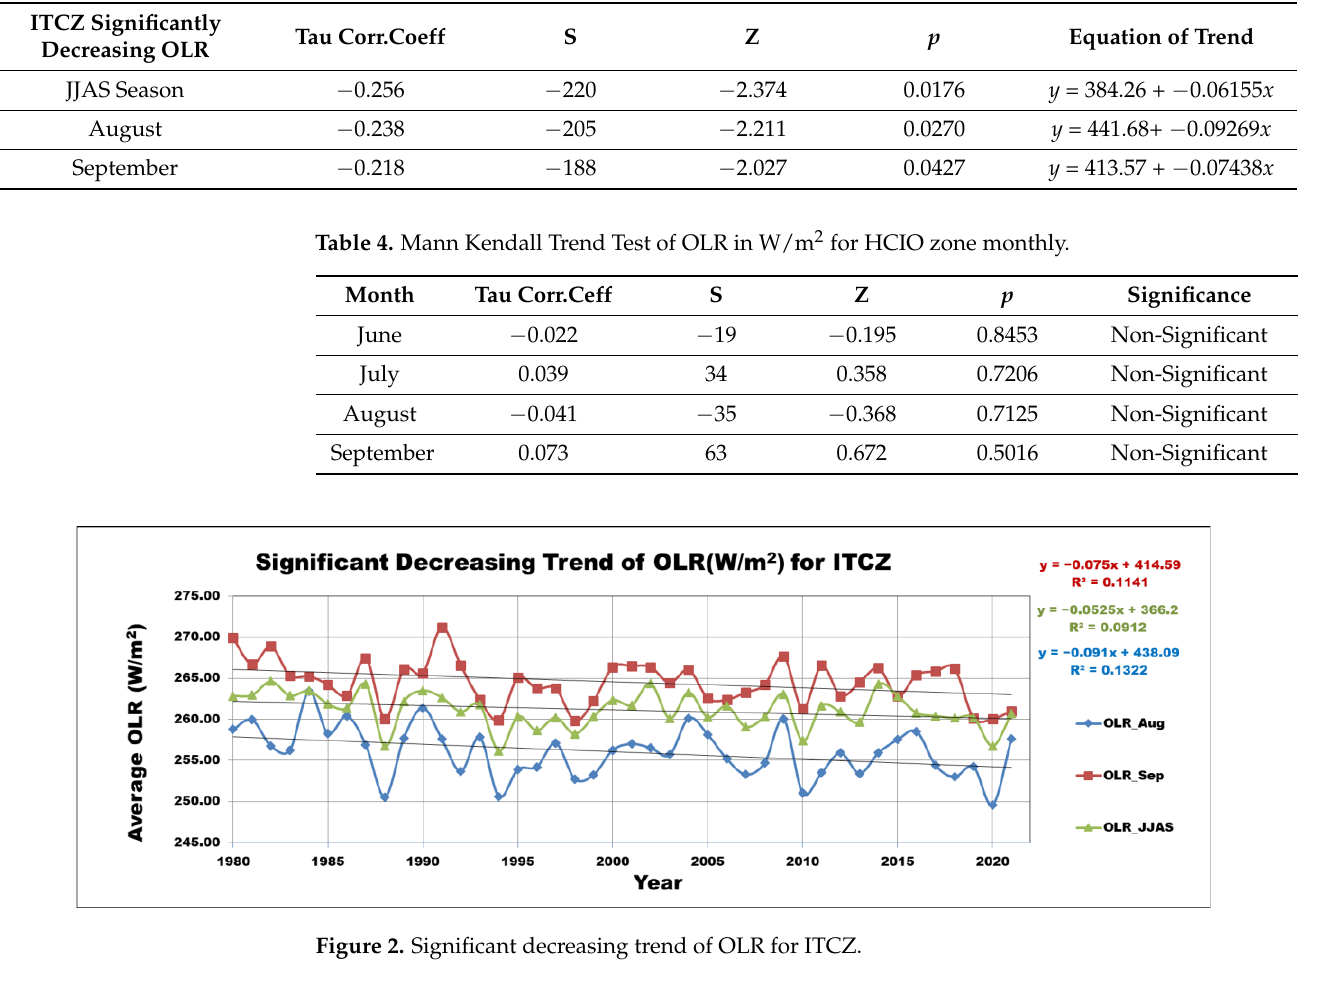
Table 3. Trend equation for the significant trend of seasonal (JJAS) and monthly OLR activity in ITCZ belt.